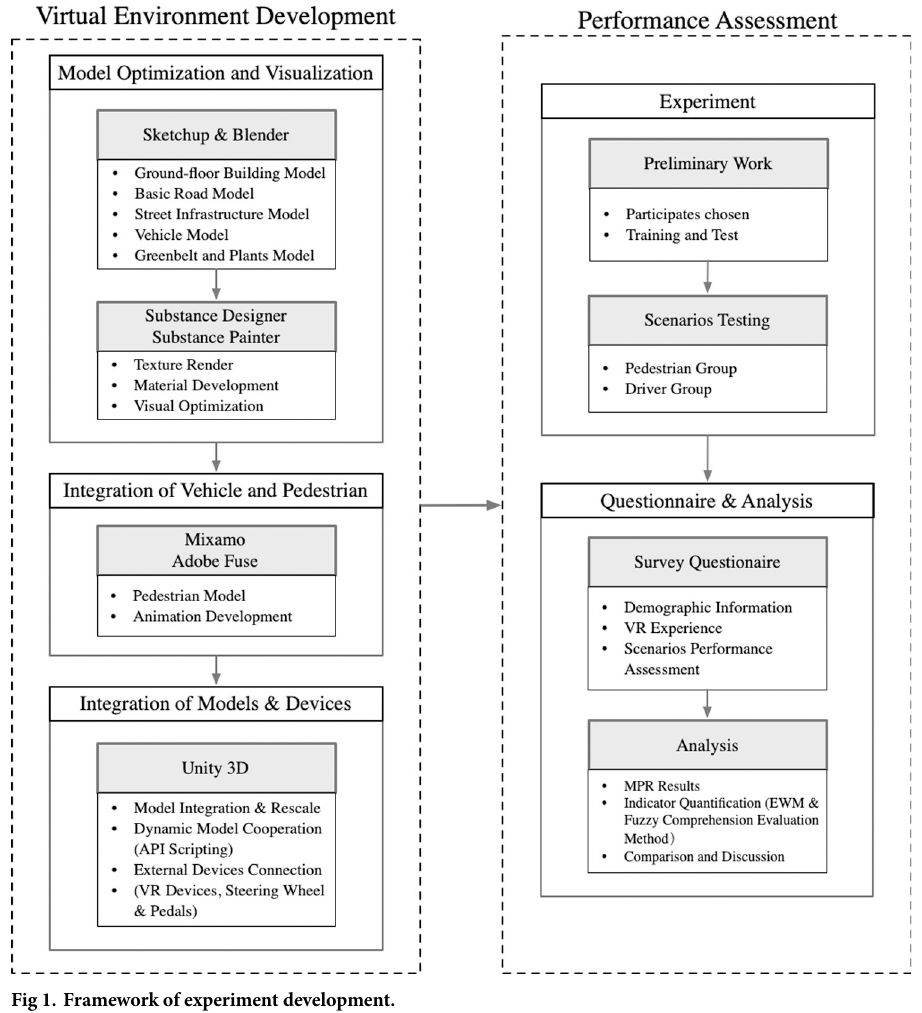
Fig 1. Framework of experiment